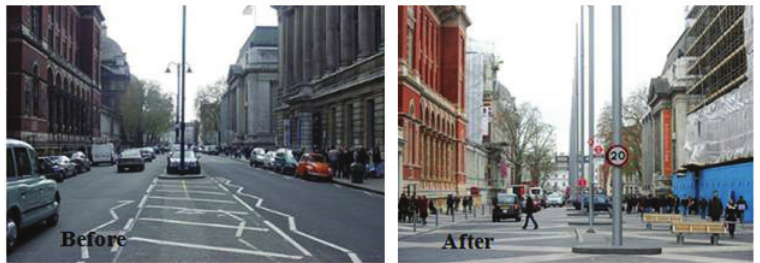
Figure 1. Changes made to exhibition road